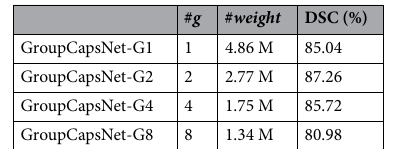
Table 2. Performance comparison of GroupCapsNets with different group